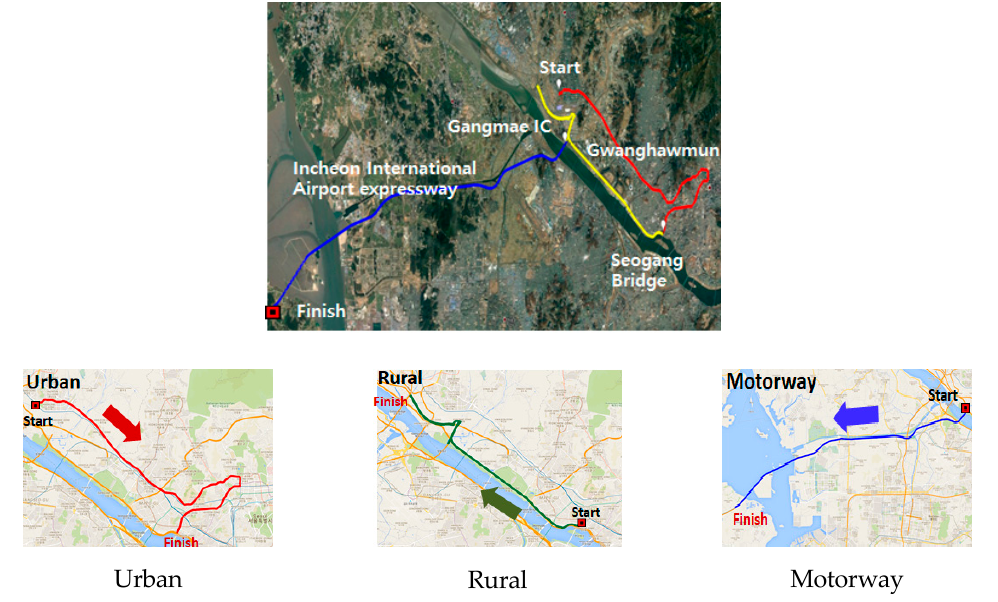
Figure 6. Driving routes for the RDE-LDV hot-start test.